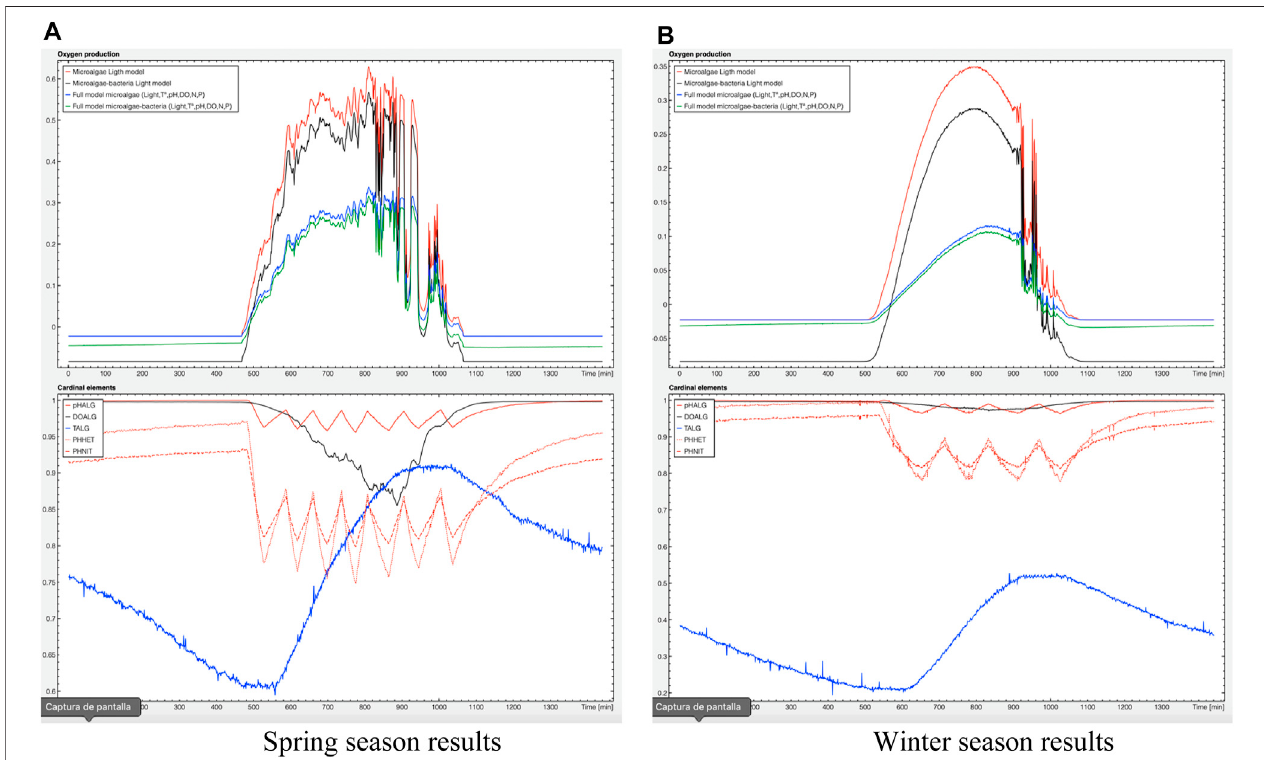
FIGURE 5 | Biological models results for different seasonal data to demonstrate the environmental variables effect on the productivity of the microalgae systems.